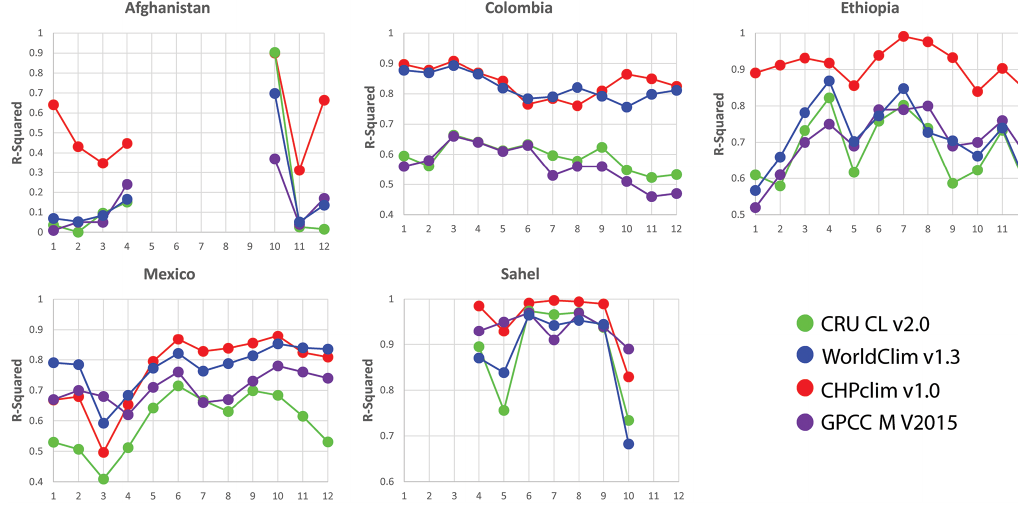
Figure 8. Spatial R 2 time